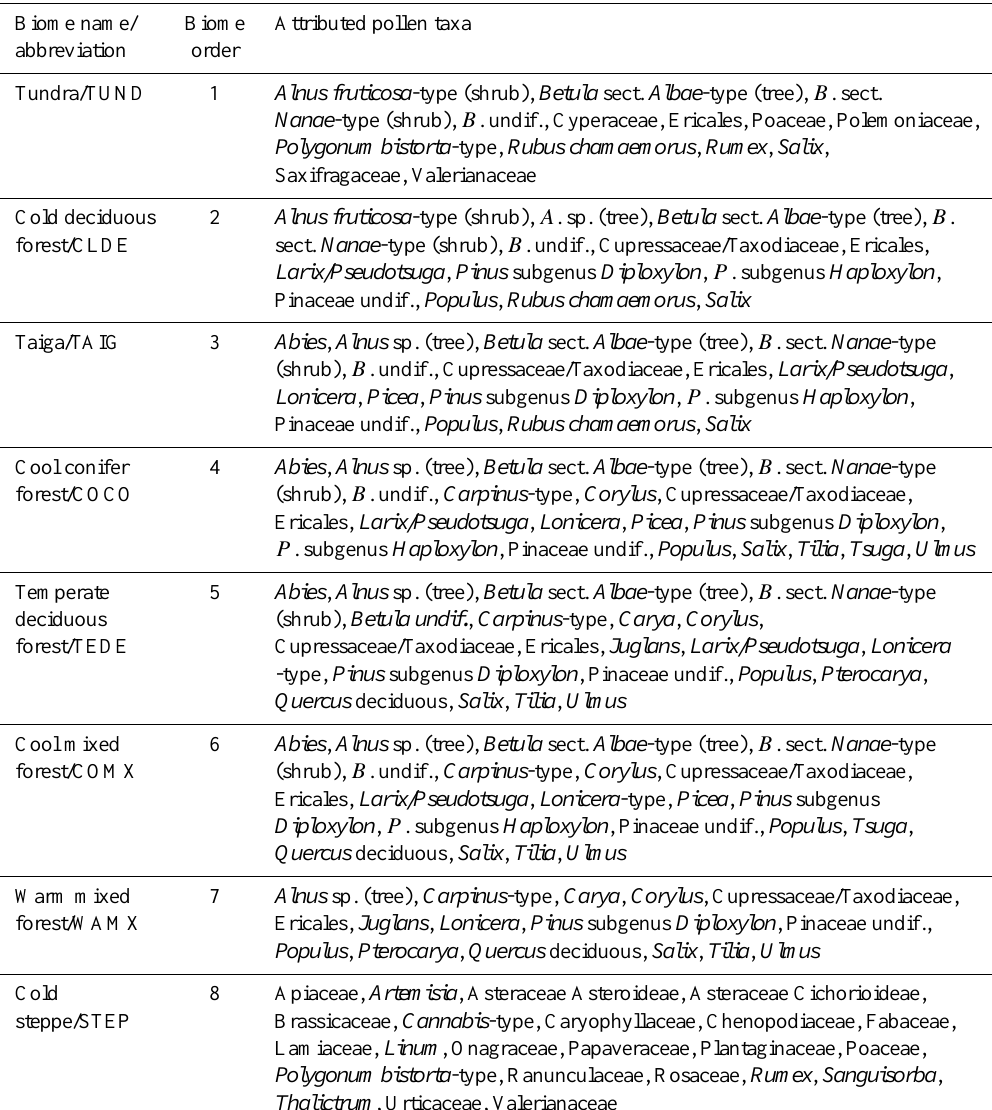
Table 1. Biome–taxon matrix used in the biome reconstruction. All terrestrial pollen taxa identified in the fossil pollen spectra in the Lake El’gygytgyn record are attributed to one or several